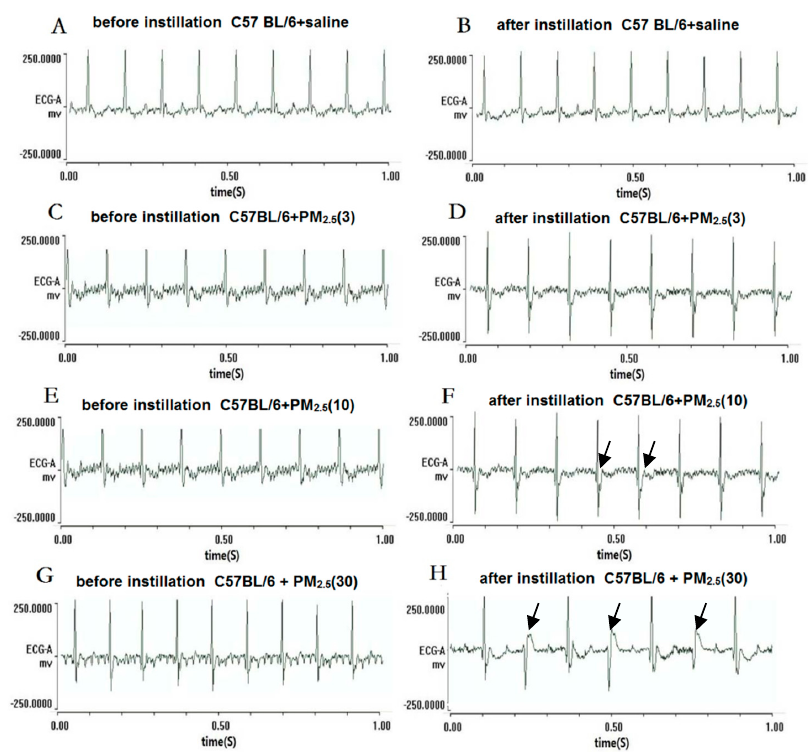
Figure 1. Electrocardiogram (ECG) types before instillation and after instillation in C57BL/6 mice. ( A , C , E , G ) represent the ECG in the mice before PM 2.5 treatment; ( B , D , F , H ) represent the ECG in the mice after PM 2.5 treatment, the doses were 0, 3, 10, and 30 mg/kg b.w., respectively; ( F ) black arrows represent ST-segment depression; and ( H ) black arrows represent ventricular escape rhythm.